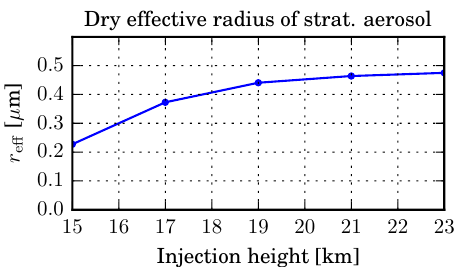
Figure 11. Global mean effective radius (µm) of the dry strato- spheric sulfate aerosol as a function of injection height (in km) in the z _KM experiments.